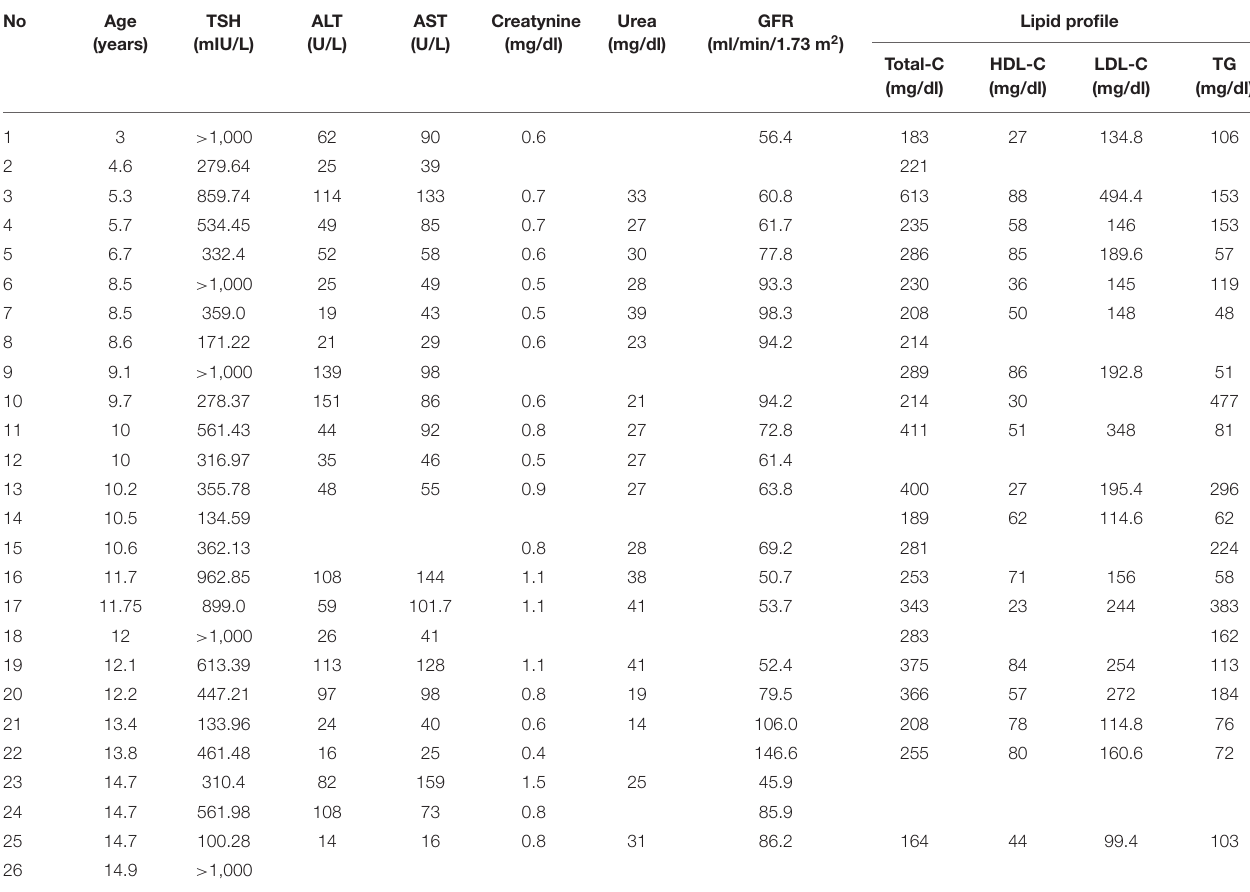
TABLE 3 | Liver and kidney function tests in children with severe